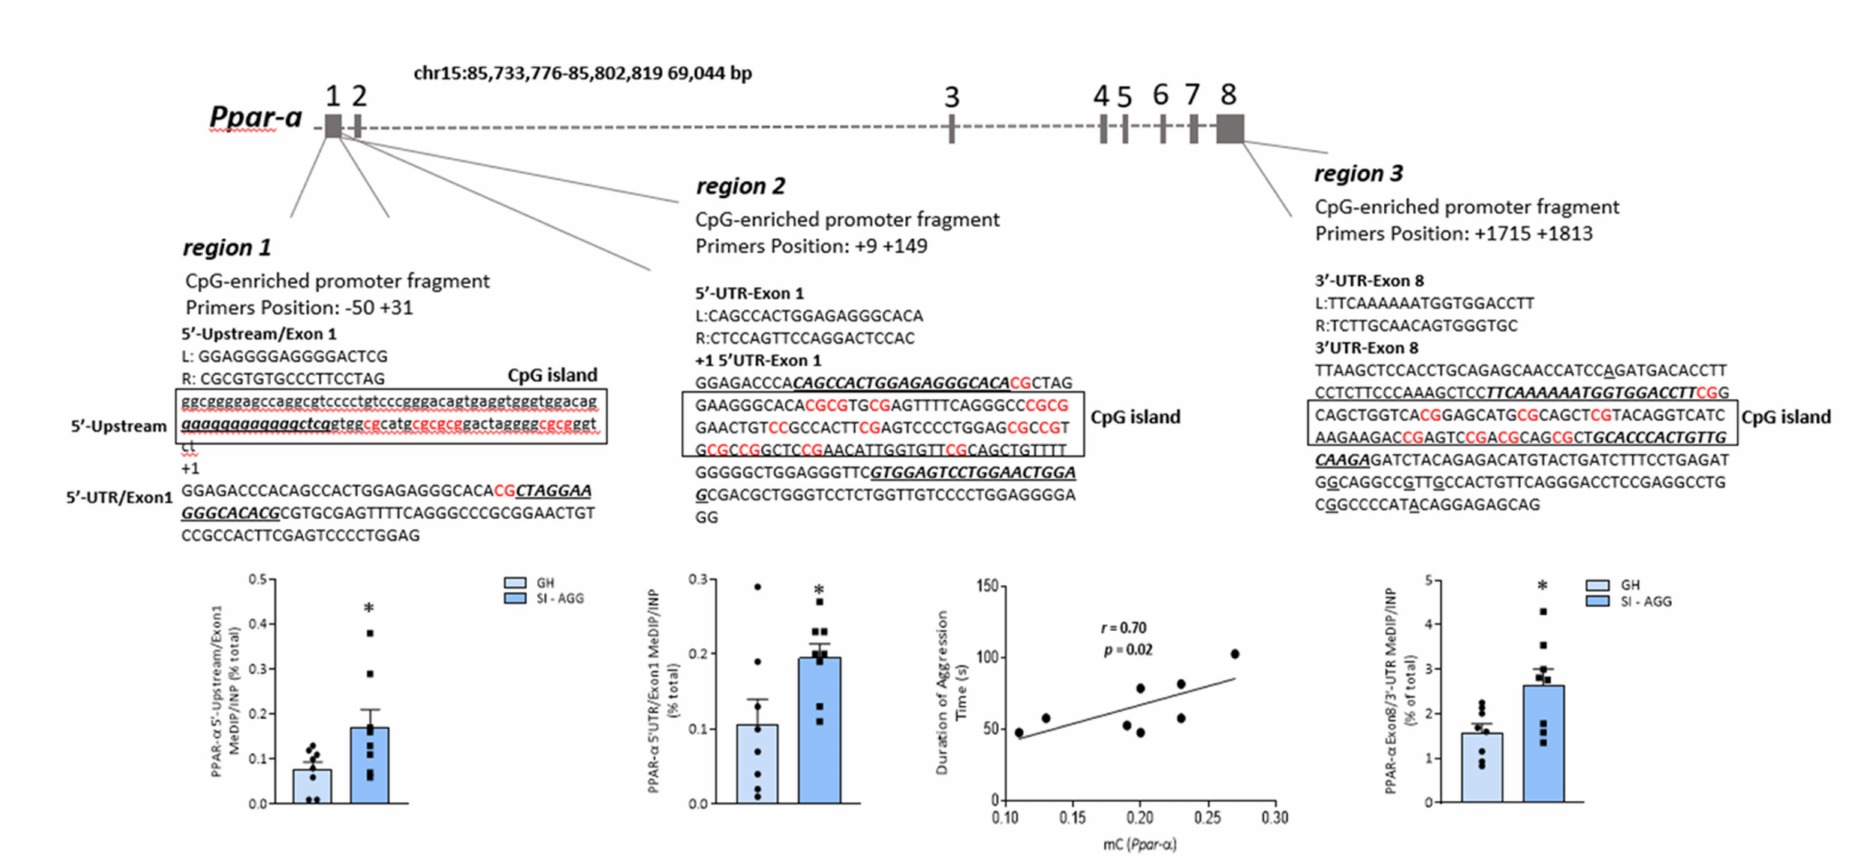
Figure 2. A schematic representation of the mouse Ppar- α gene organization. The mouse Ppar- α gene is located on chromosome 15 and contains eight exons. Based on the characterization of the human Ppar- α gene reported by Pineda Torra (2002) [23], we selected three different fragments of the gene rich in CG dinucleotides within the proximal promoter, 5 (cid:48) -UTR (within exon 1), or 3 (cid:48) UTR portions of the gene and amplified by specific primers using the qPCR technique. The selected region (region 1) consists of a CpG-enriched promoter fragment positioned at − 50/+31 bp linking the 5 (cid:48) -upstream promoter region to the 5 (cid:48) -UTR fragment of Exon 1. Region 2 amplified the 5 (cid:48) -UTR and part of exon 1 after the transcription starting nucleotide (+1) positioned at +9 +149 bp, whereas region 3 covered the 3 (cid:48) -UTR and part of the exon 8 positioned at +1715 +1813 bp. The increase in cytosine methylation levels was measured by methylated DNA immunoprecipitation (MeDIP) of the Ppar- α gene fragments (region 1: unpaired t test: * p = 0.04, t = 2.23, df = 14, n = 8; region 2: * p = 0.03; t = 2.30; df = 14; n = 8; region 3: * p = 0.02; t = 2.59; df = 14; n = 8). In addition, a positive correlation between methylated cytosines (mC) levels of region 2 and aggressive behavior was observed (Pearson’s r = 0.70; * p = 0.02; n =